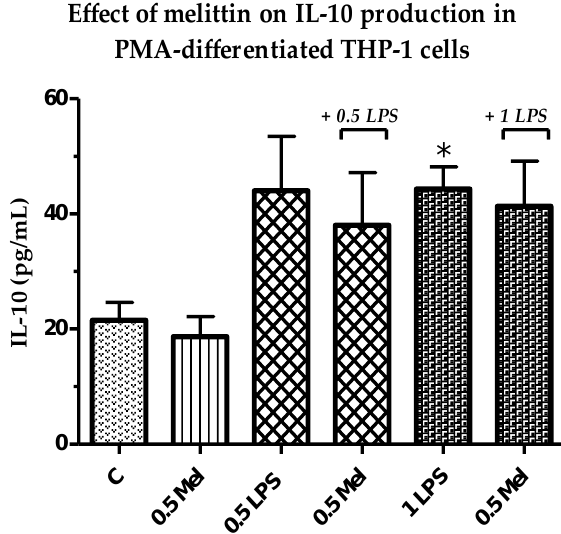
Figure 5. Effect of melittin on the production of IL-10 cytokine in the presence and absence of LPS on PMA-differentiated THP-1 cells. Melittin was tested at a 0.5 µg/mL final concentration in combination with LPS (0.5 and 1 µg/mL) ( n = 3). C: control; Mel: melittin; LPS: lipopolysaccharide; *: Significant ( p < 0.05).